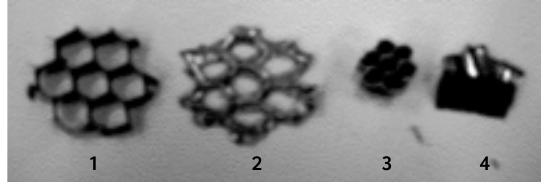
Fig. 9. Honeycomb specimens for dynamic testing ACG before (1) and after (2), CR-III before (3) after (4).